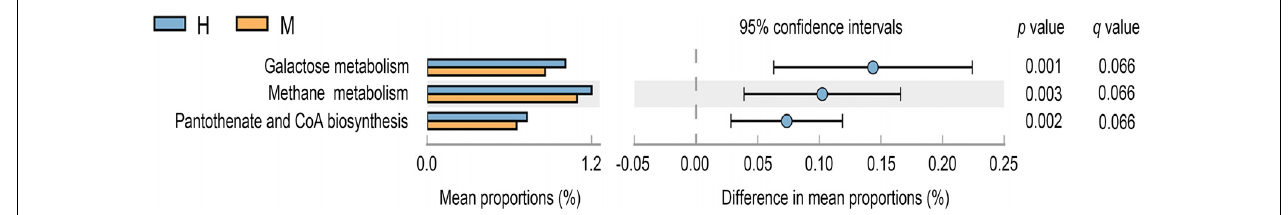
FIGURE 4 | Differential KEGG pathways at level 3 for the fecal microbiome of MSA and healthy groups. Mean proportions are shown in stacks for MSA (orange) and healthy (blue) groups. Difference in mean proportions = mean proportions in healthy group minus mean proportions in MSA groups. q values were calculated through Storey’s FDR